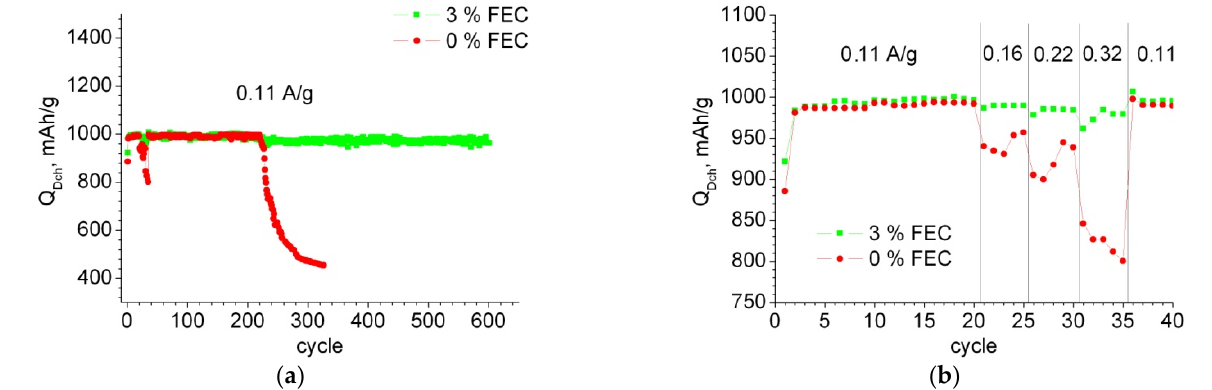
Figure 2. Dependence of specific discharge capacity on the cycle number for samples with 0% and 3% FEC: ( a ) throughout the experiment, ( b ) during the first 40 cycles at different currents shown in the graph.